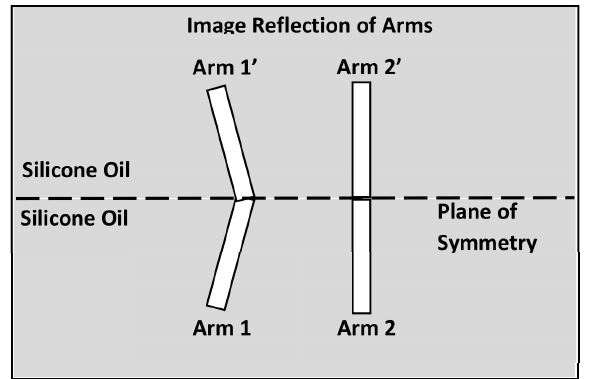
Figure 7. An image system featuring a symmetric robot immersed completely in silicone oil. This system is obtained by reflecting the region below the air-oil interface.